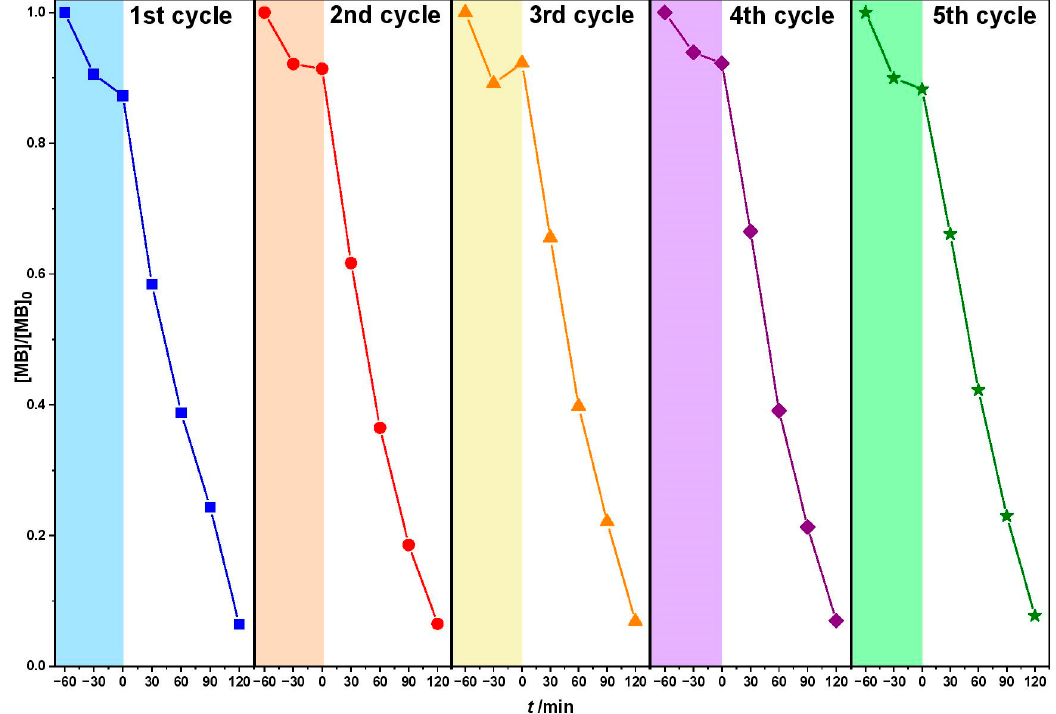
Figure 7. The recyclability of immobilised rGO/TiO 2 photocatalyst during removal of MB from an aqueous medium (milli-Q water) using simulated solar irradiation.